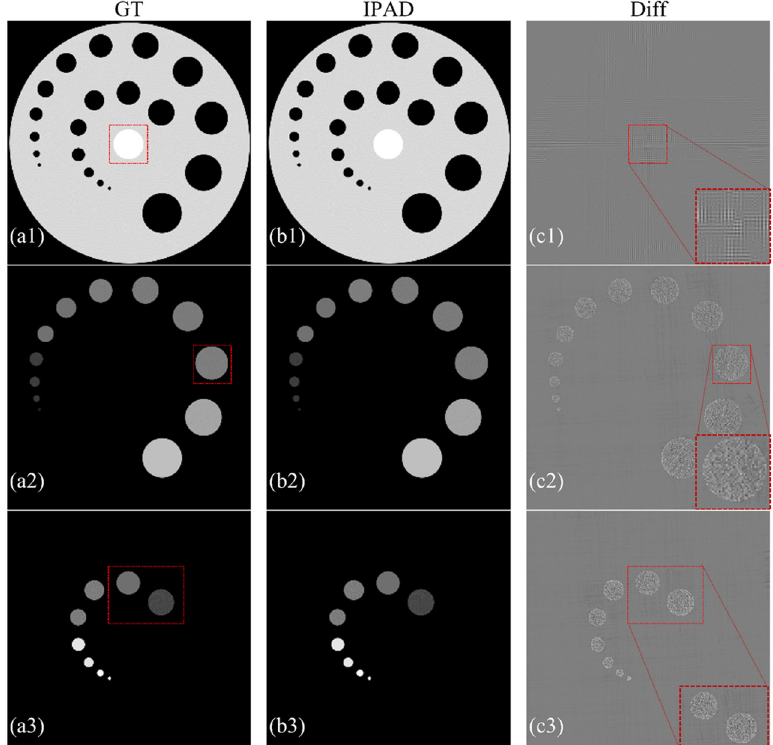
Figure 2. Results of the noise-free simulation dataset obtained by the proposed IPAD method. ( a1 )– ( a3 ), ( b1 ) – ( b3 ), and ( c1 ) – ( c3 ) represent the tissue, bone, and iodine obtained by the GT, the proposed IPAD method, and their differential images, respectively, where the display windows of the first two columns are [0.01 1], [0.01 1], and [0.01 0.5], respectively. The corresponding differential maps are shown in a 0.1% grayscale window [ − 0.005 0.005] for tissue and a 0.01% grayscale window [ − 0.0001 0.0001] for bone and iodine.